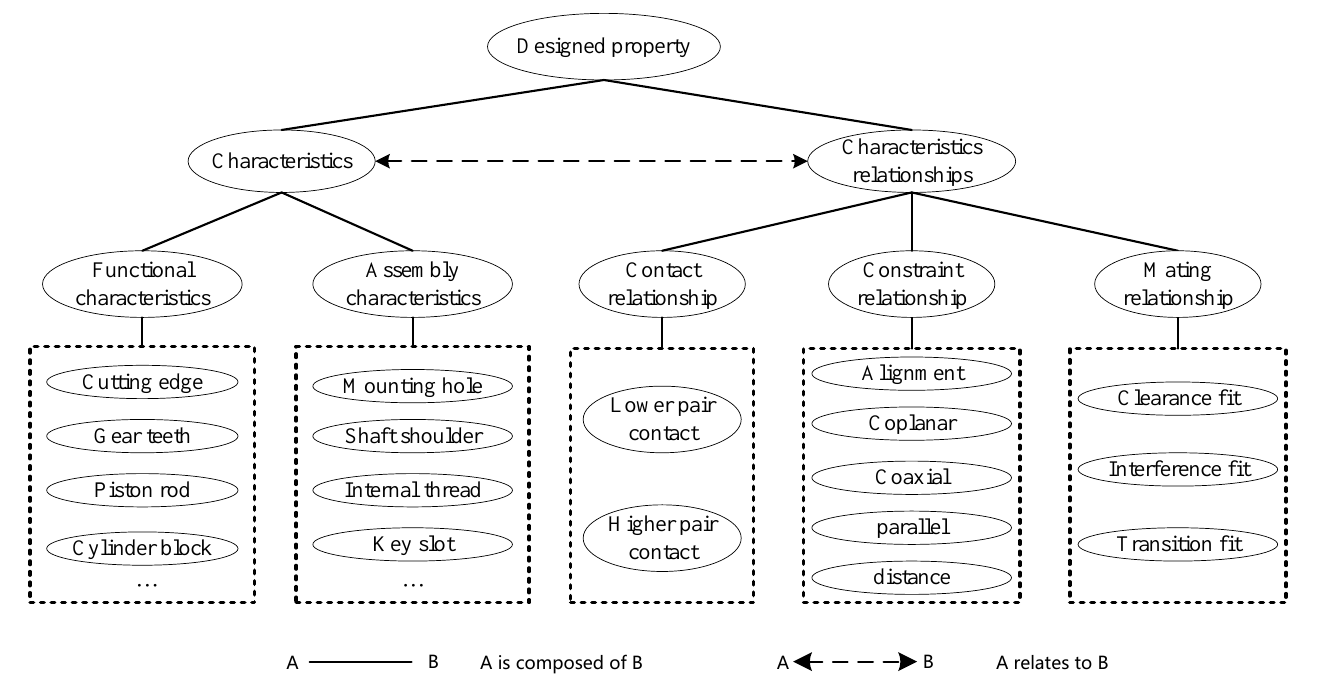
Figure 2. The characteristics and the characteristic relationship model of designed properties.